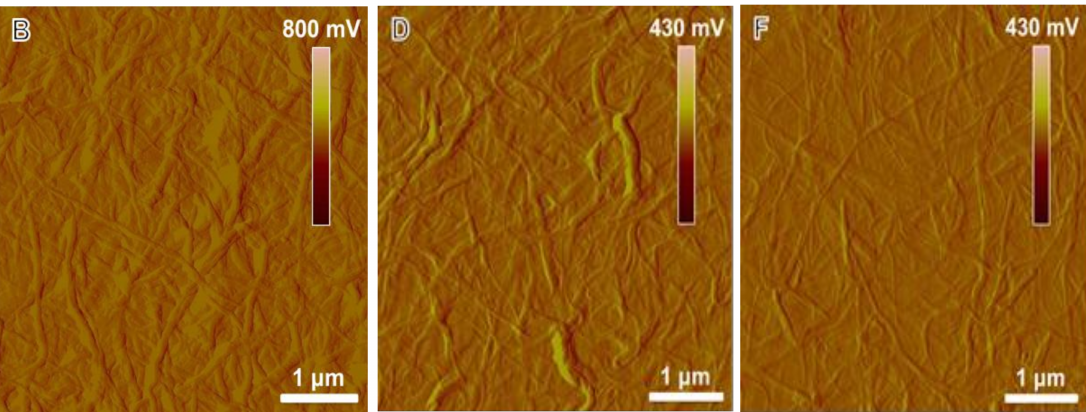
Figure 8. AFM height ( A , C and E ) and amplitude ( B , D and F ) microgrqaphs of rGO-SWNT